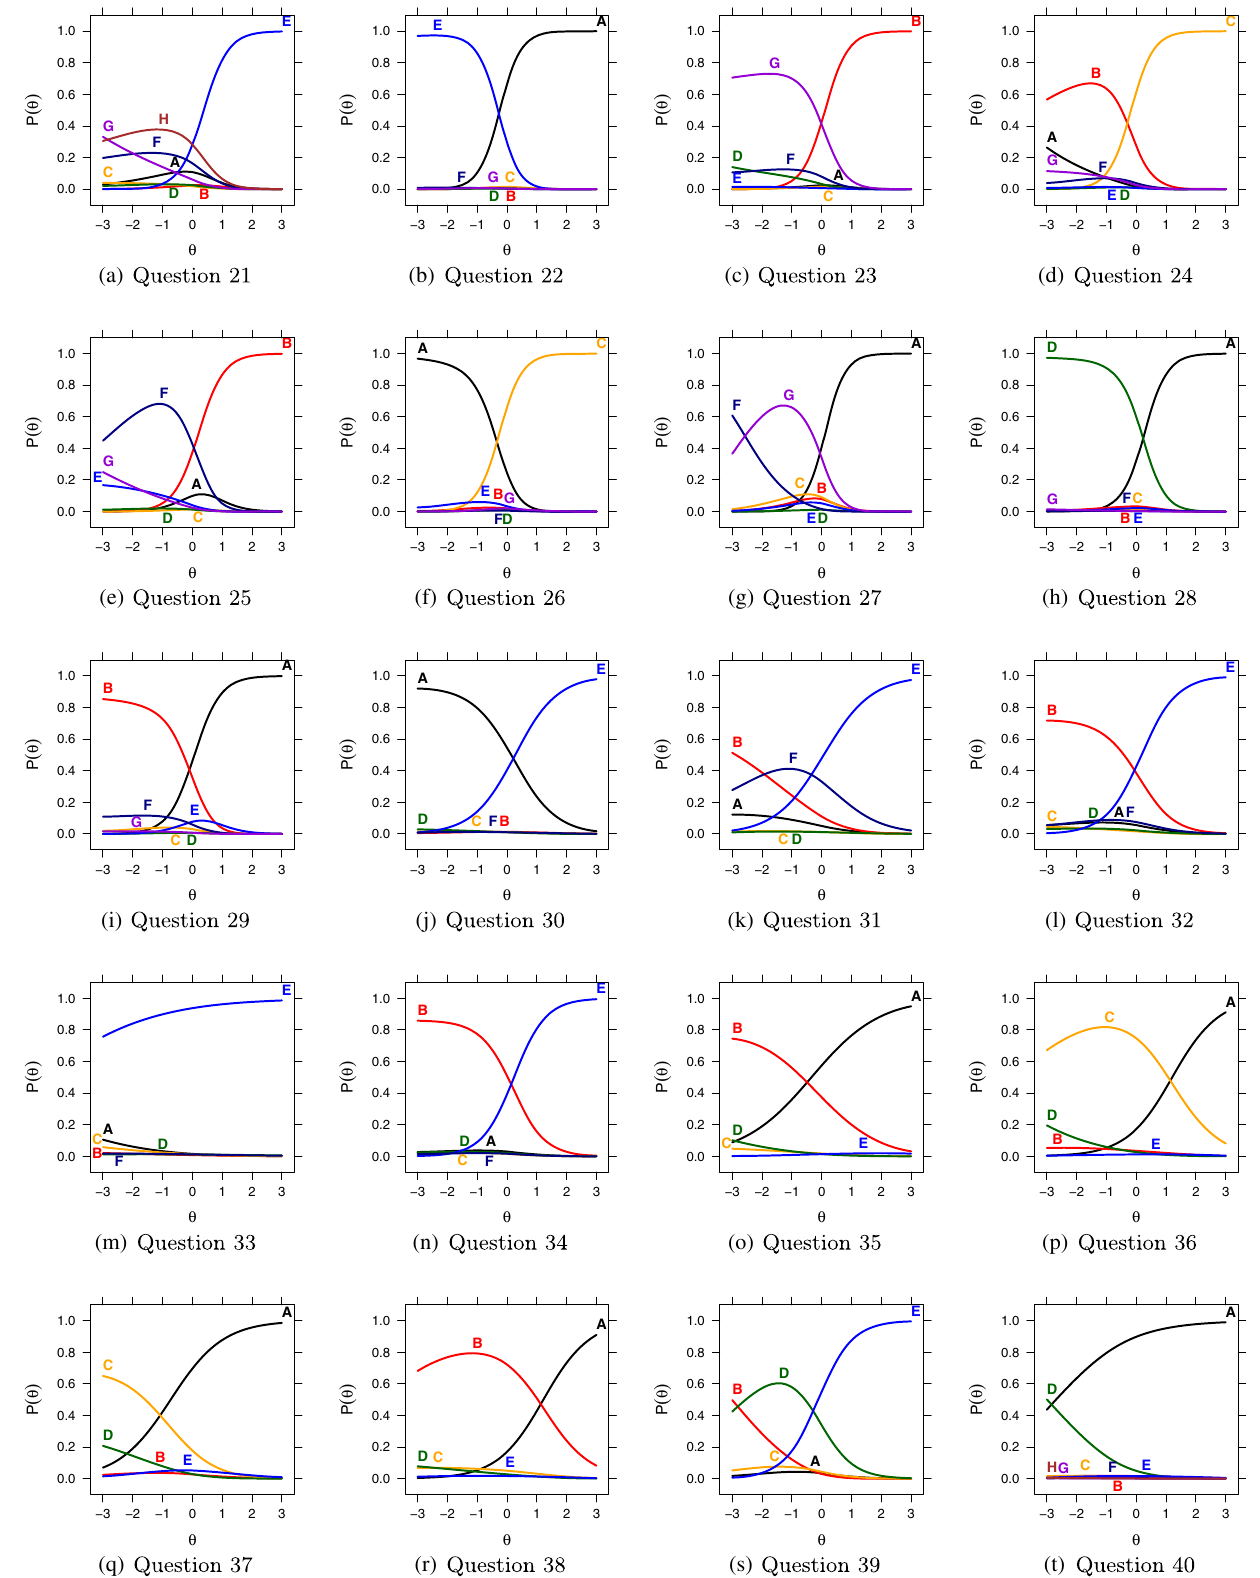
FIG. 7. IRT plots from the 2PL-NRM nested logit model for questions 21 –